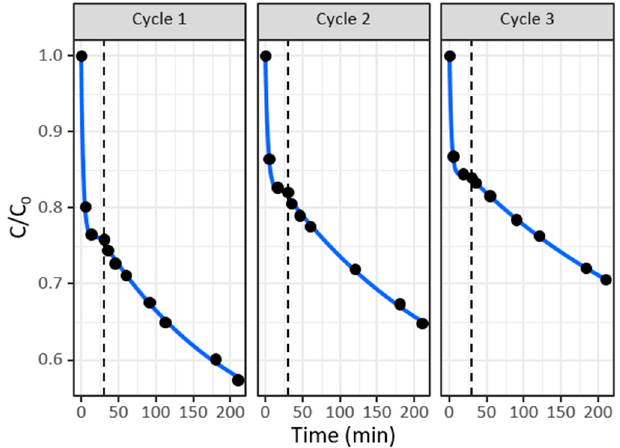
Figure 12. Reusability of the photocatalyst SnO2CLI25 in photodegradation of MB. The illumination part of the reaction, right of the dashed line, is fitted to Equation. 1 with a blue solid line. Reaction conditions: V = 50 cm 3 , O 2 flow = 25 cm 3 min –1 , T = 22 °C, C 0 = 10 mg dm -3 , m cat = 10 mg.